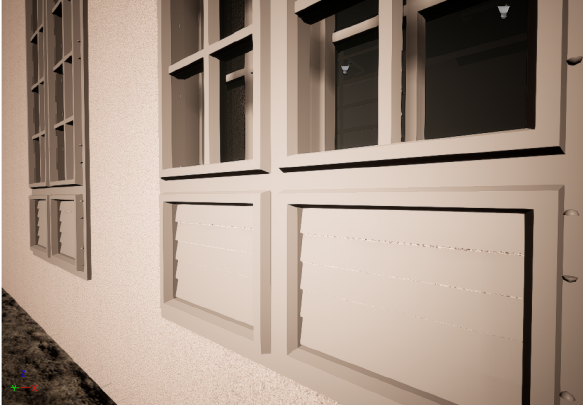
Figure 5 . Example of atypical window. The following figure shows the connection error of horizontal and vertical building structures that are not connected correctly. In the corner of the building, a space was created that is not filled with masonry. This is an example of a topological error - wrong connection of masonry.